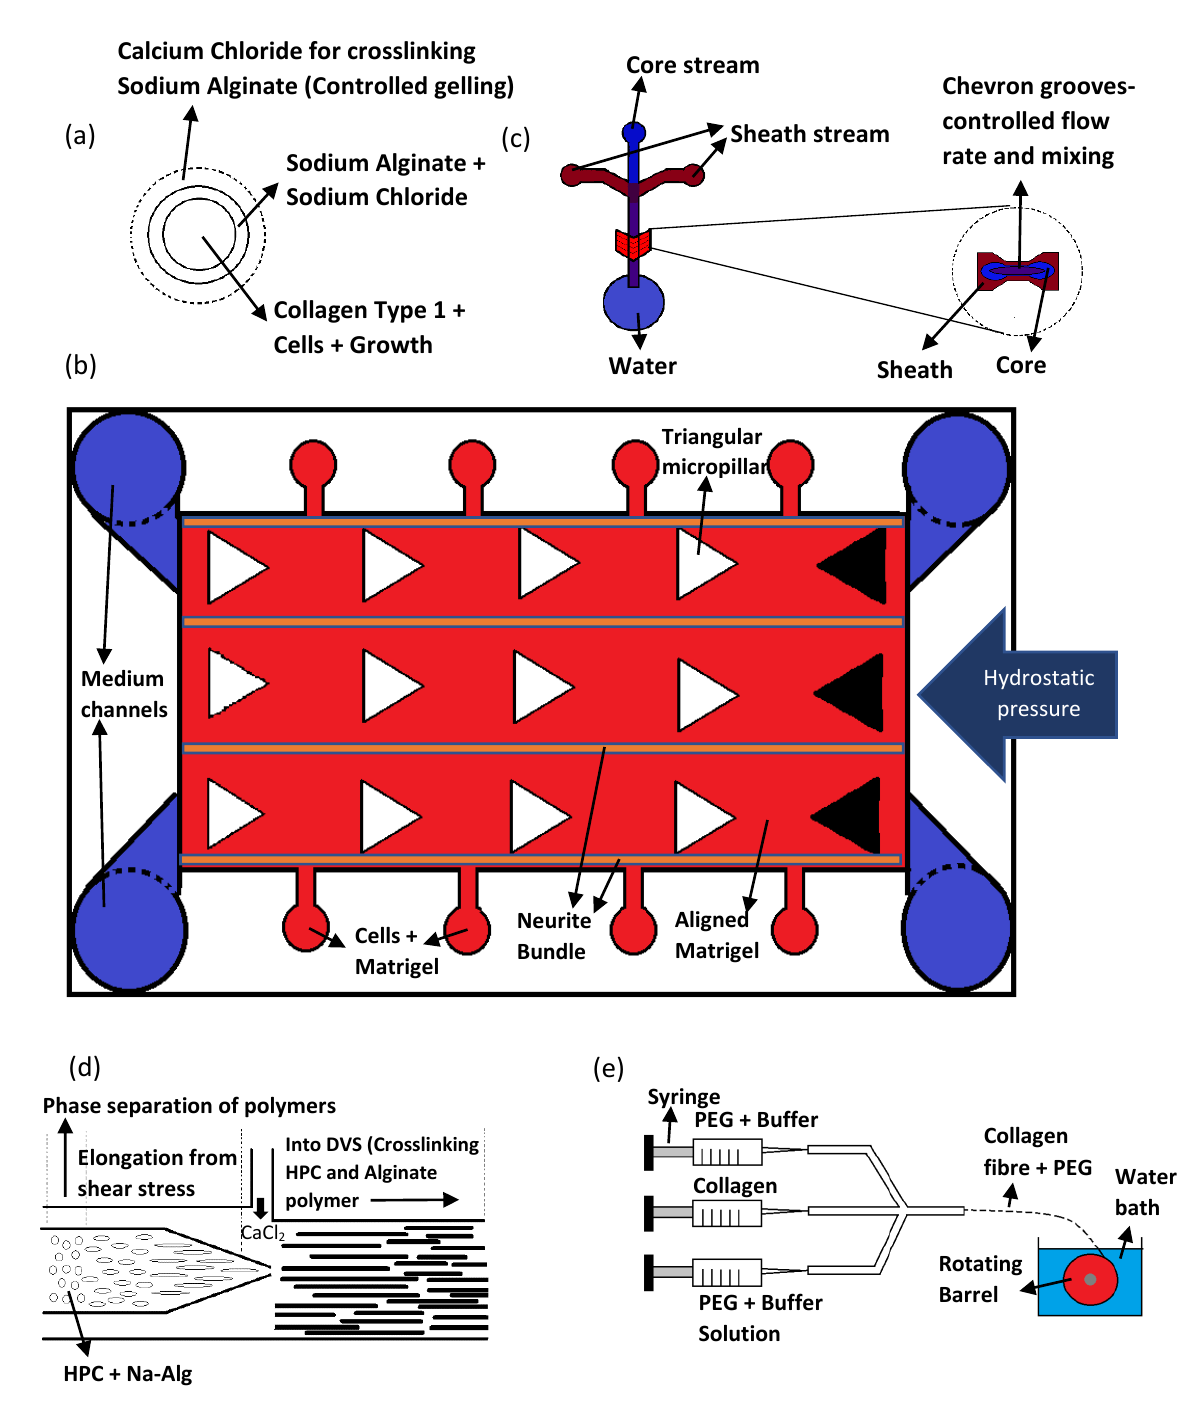
Figure 5. Schematics of various microfluidics devices. ( a ) Cross-section of the microfluidic channel. ( b ) A top view of the microfluidic device. ( c ) The cross-section of the chevron grooves. ( d ) A side way cross-section of the microfluidic channel. ( e ) The microfluidic setup coupled with a wet pinning method.